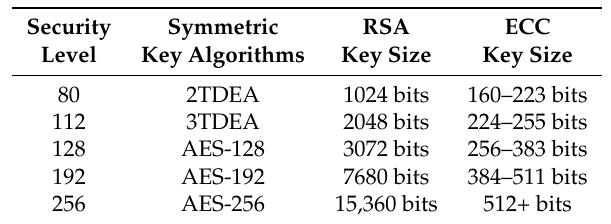
Table 2. Comparable strengths for symmetric, Rivest–Shamir–Adleman (RSA) and Elliptic Curve Cryptography (ECC)